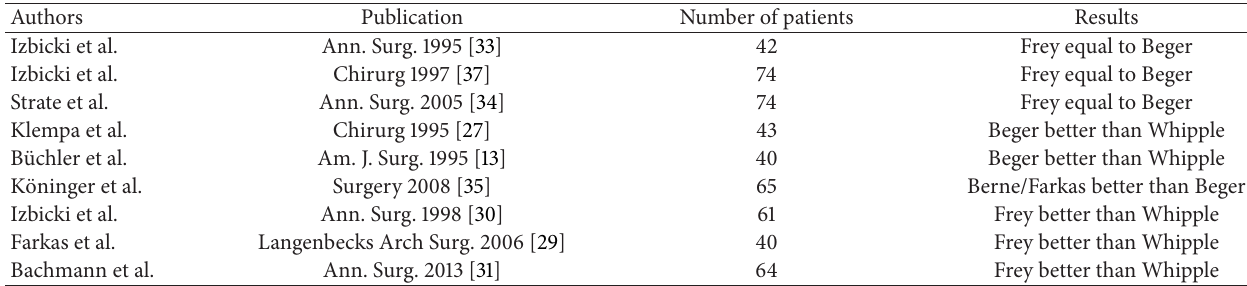
Table 3: Randomized controlled studies on the surgical treatment of painful